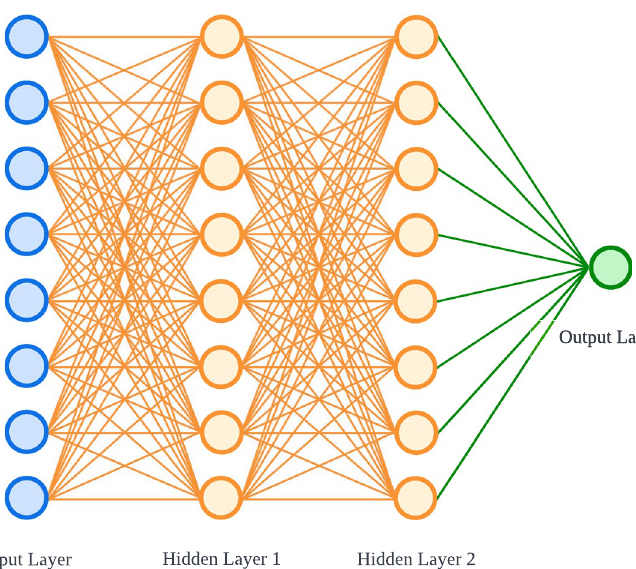
Fig. 6 Deep learning model for malaria risk